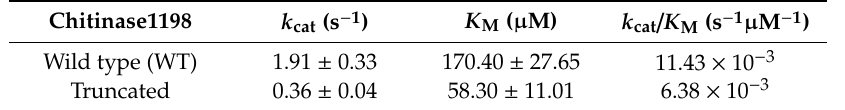
Table 3. Comparison of kinetic parameters of di ff erent chitinase 1198 constructs on pNP-(GlcNAc) 2